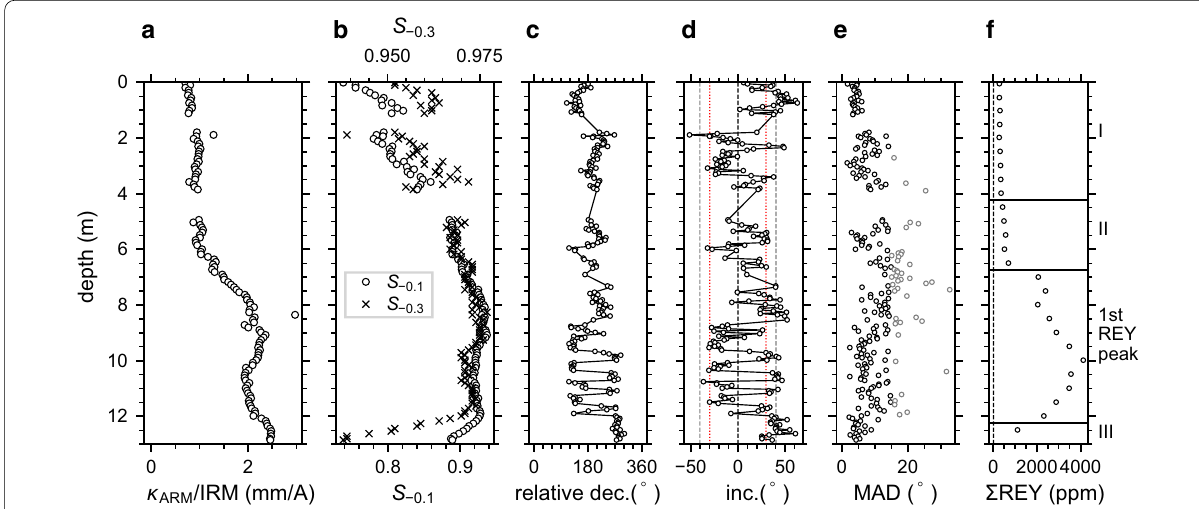
Fig. 1 Depth variations of rock magnetic and paleomagnetic results. a κ ARM /SIRM. b S ratios. Open circles represent S c Relative declination. The core was not azimuthally oriented with respect to the geographic coordinates. d Inclination. Vertical lines show expected inclinations for geocentric axial dipole. Gray dashed lines are for 24º latitude (present day), and red dotted lines are for 16º latitude (~ 35 Ma; Matthews et al., 2016). e Maximum angular deviation (MAD). Gray symbols show data with MAD > 15°, which are not plotted in c and d . f Variation of total REY content (Iijima et al., 2016). On the right are chemostratigraphic Units of Tanaka et al.